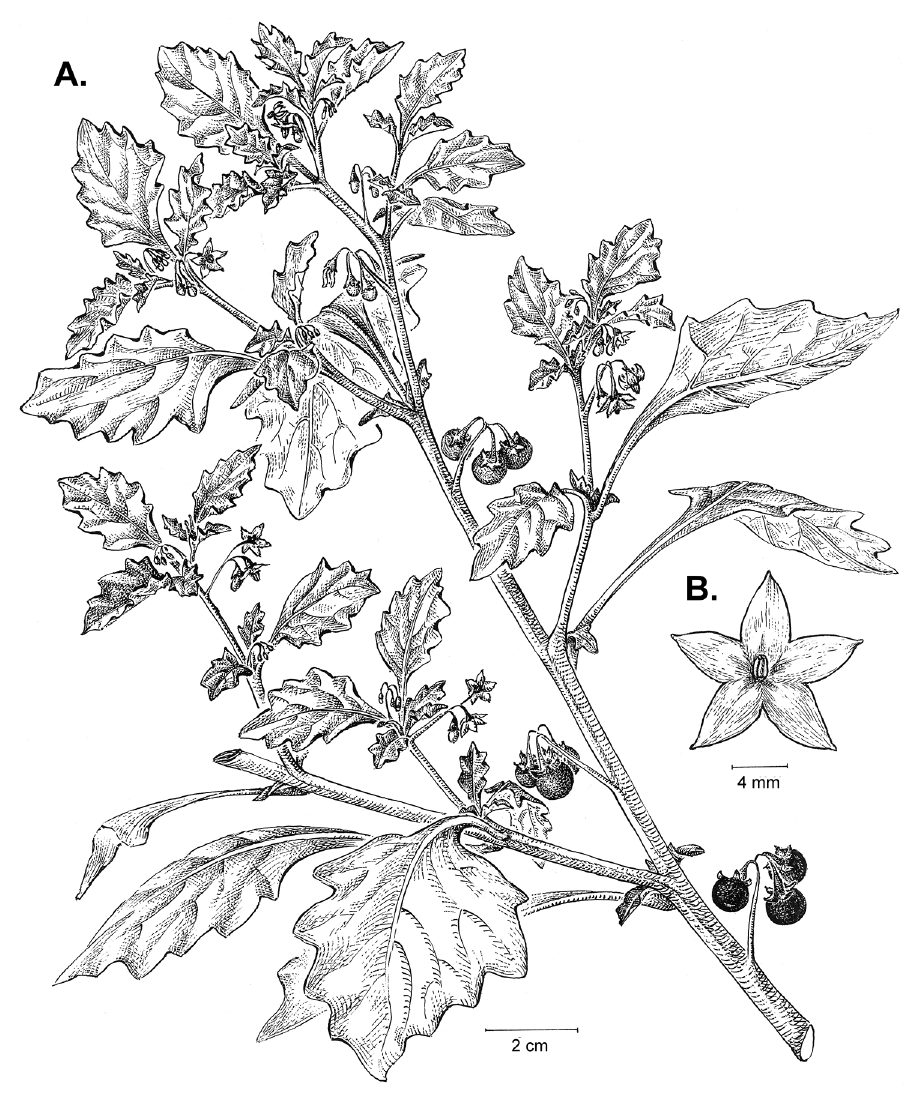
Figure 42. Solanum retroflexum Dunal. A Habit B flower. Drawing by M.L. Szent-Ivany, first published in Symon (1981), courtesy of the Board of the Botanic Gardens and State Herbarium (Adelaide, South Australia), reproduced with permission (previously also published in “PhytoKeys